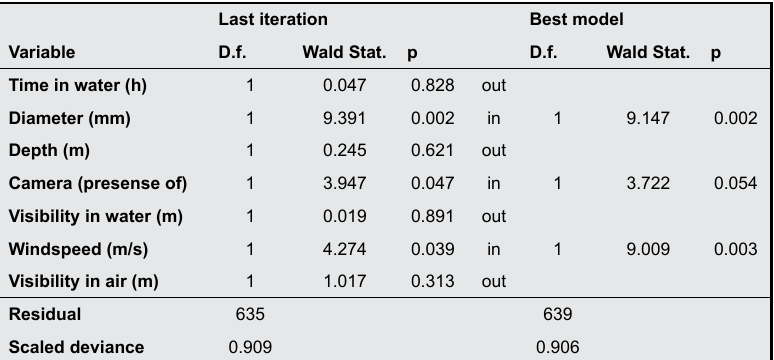
Table 5 . Result of a forward stepwise logistic regression in the buoy experiment, using primary and secondary variables, and a logistic regression based on variables selected by the forward proce- dure (best model). Values for the last iteration were reached when adding more variables did not improve the model.